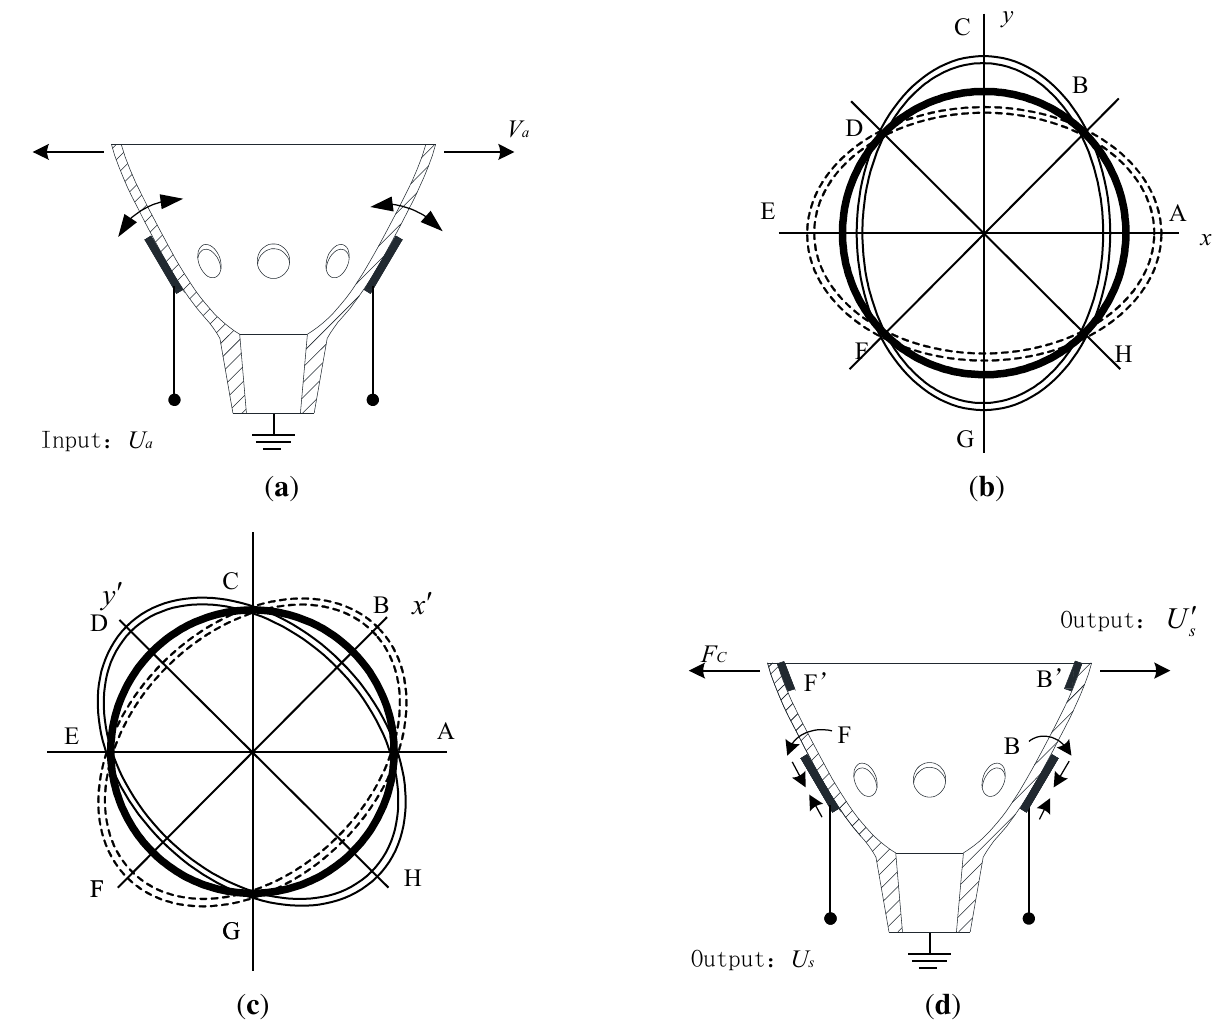
Figure 5. Schematic of the working